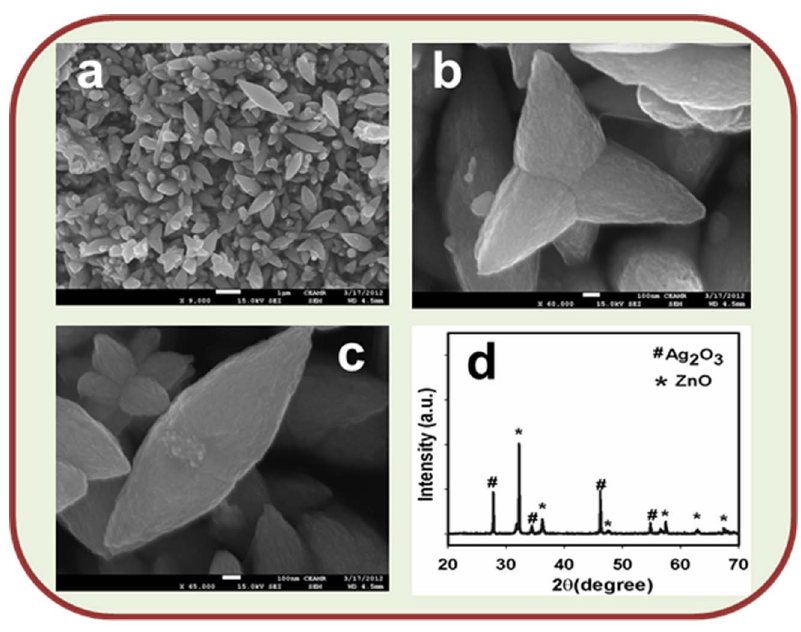
Figure 2. Studies of Morphology and Crystallinity. (a–c) FESEM images and (d) Powder x-ray diffraction pattern of calcined Ag 2 O 3 -ZnO NCs at room